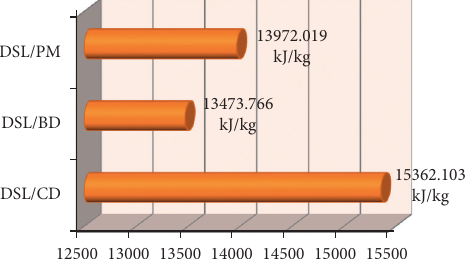
Figure 13: NCV of the briquettes with different binders.